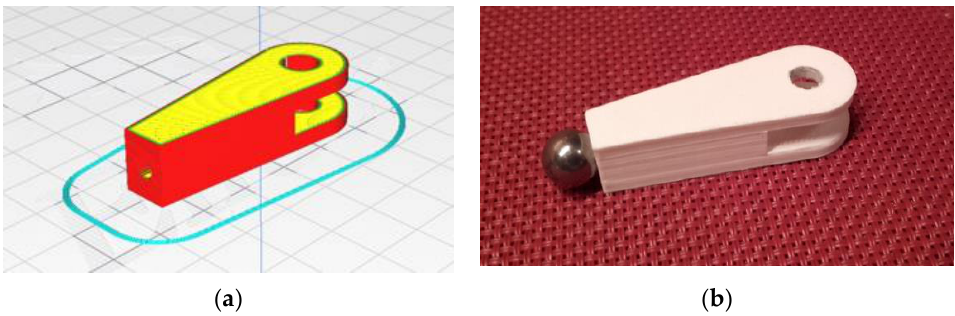
Figure 5. Servo motor arm crank part: ( a ) Visualization in Ultimaker Cura software; ( b ) Actual 3D print.